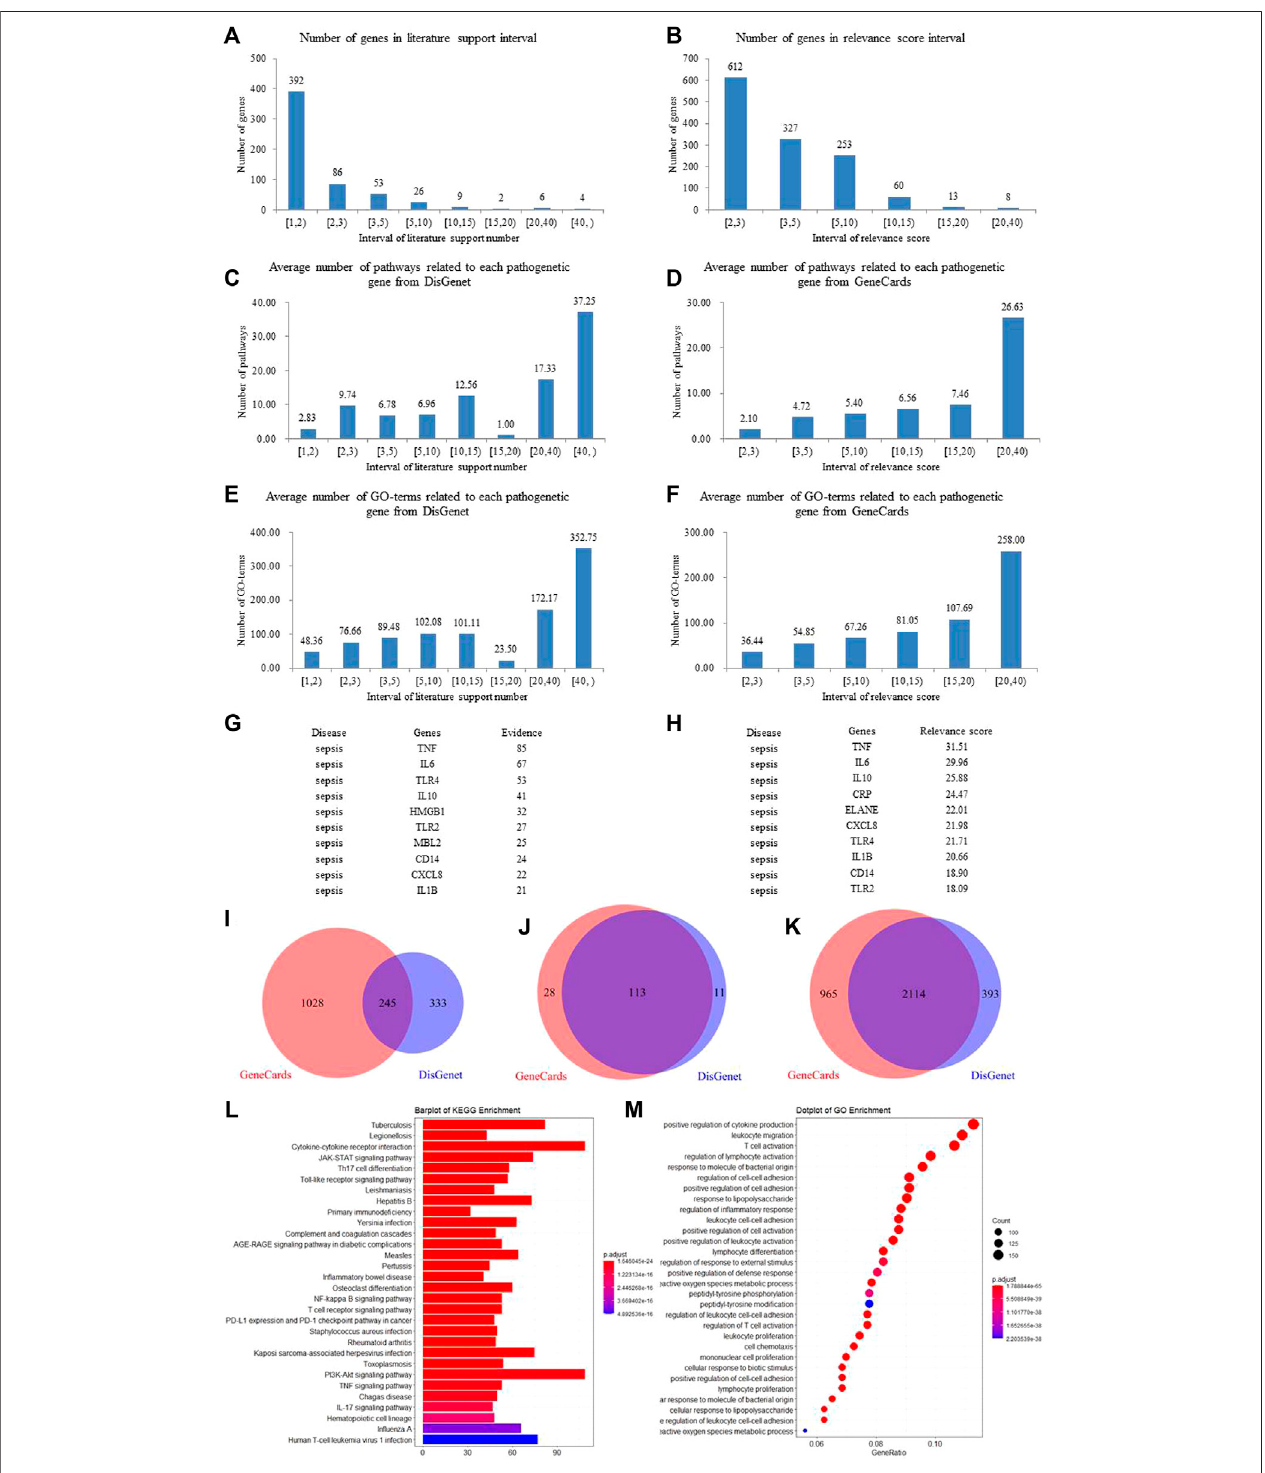
FIGURE 2 | Study situations of pathogenetic genes. (A,B) Genes from DisGeNET and GeneCards, respectively. (C,D) KEGG enriched analysis of the genes from DisGeNET and GeneCards, respectively. (E,F) GO enriched analysis of the genes from DisGeNET and GeneCards, respectively. (G,H) The top 10 genes of DisGeNET and GeneCards valued on the numbers of supported literatures and relevance scores, respectively. (I – K) Interactions of genes, pathways, and GO-terms of the genes form DisGeNET and GeneCards. (L,M) KEGG and GO enrichments of pathogenetic genes.